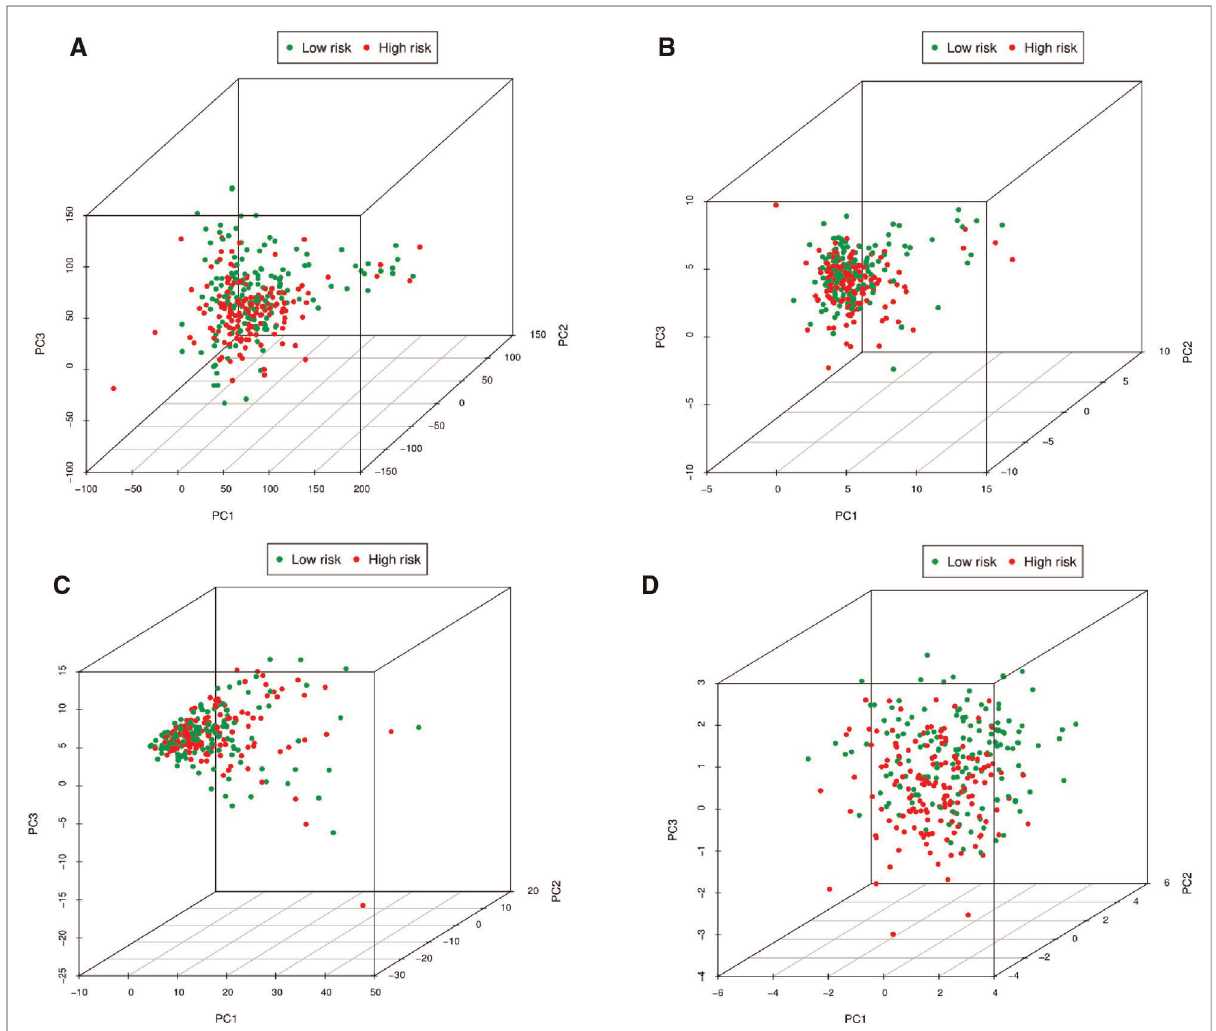
FIGURE 11 Principal component analysis between low-risk and high-risk patients. ( A ) PCA of expression differences of all genes between low-risk and high-risk OSCC patients. ( B ) PCA of expression differences of pyroptosis-related genes between low-risk and high-risk OSCC patients. ( C ) PCA of expression differences of pyroptosis-related lncRNAs between low-risk and high-risk OSCC patients. ( D ) PCA of expression differences of eight pyroptosis- related lncRNAs between low-risk and high-risk OSCC